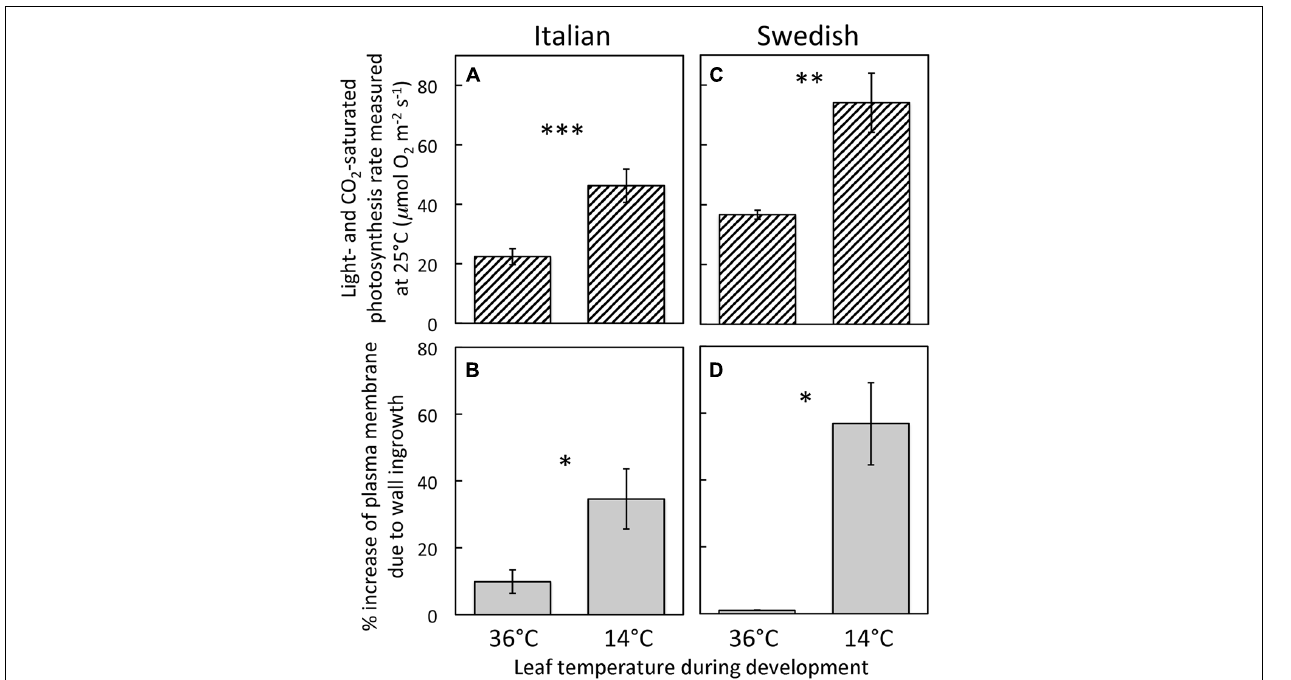
FIGURE 4 | (A,C) Foliar light- and CO 2 -saturated rate of photosynthetic oxygen evolution ascertained at 25 ◦ C and (B,D) percent increase in plasma-membrane length due to cell-wall ingrowths estimated from cross-sections of phloem-parenchyma transfer cells relative to the hypothetical membrane area in the absence of wall ingrowths in foliar minor veins of Italian (A,B) and Swedish (C,D) ecotypes of